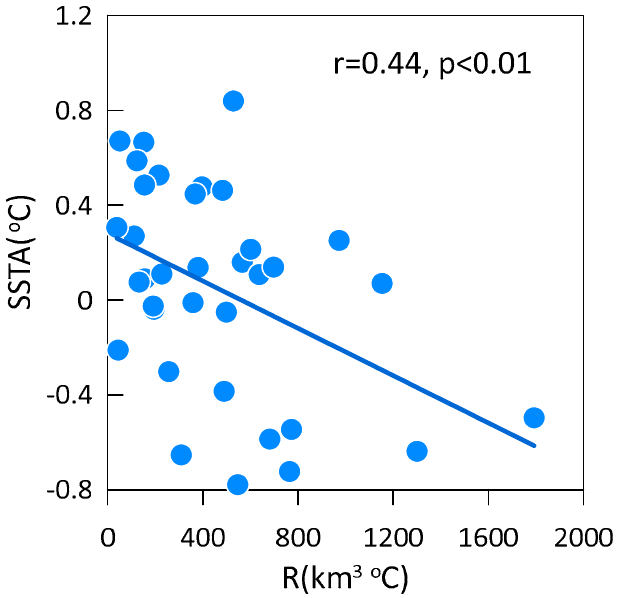
Figure 8. Relationship between upwelling intensity (R) and SSTA for the coastal upwelling system of the Taiwan Strait.